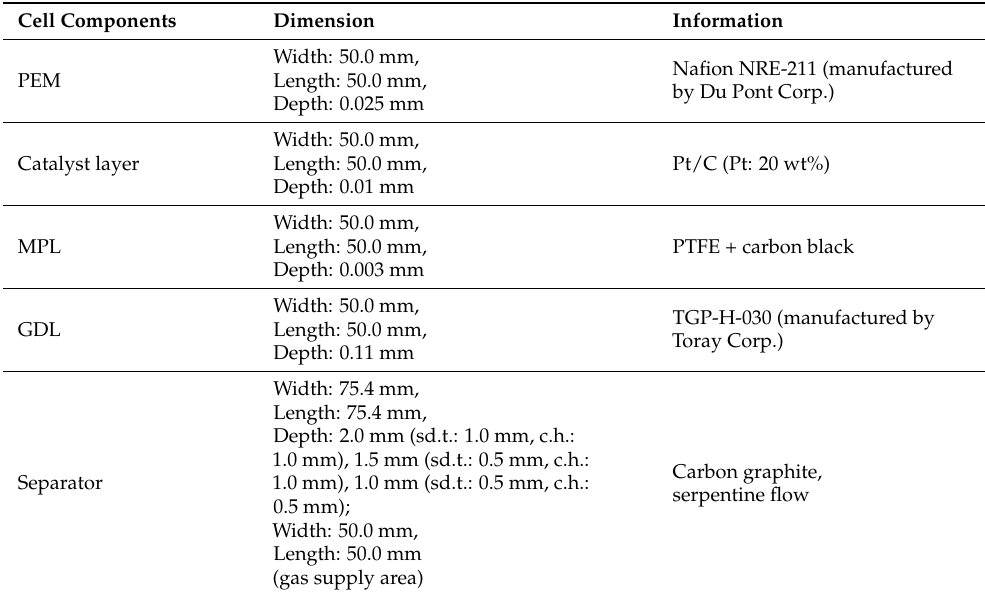
Table 1. Geometrical parameters of components in single cell of PEFC applied for 3D model in the numerical simulation in this study [14,29–33].